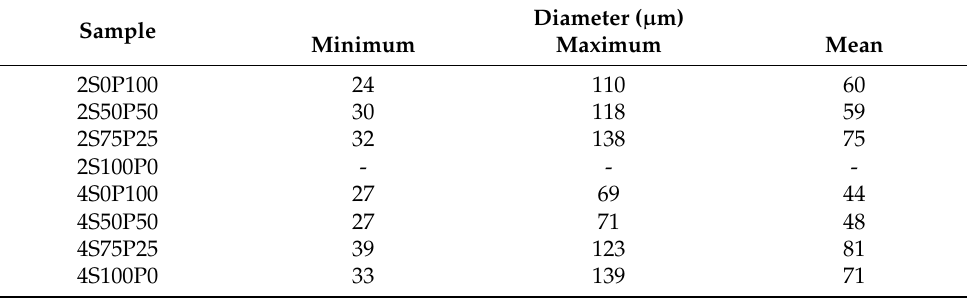
Table 3. The average pore diameter on the surface of the hydrogel samples.